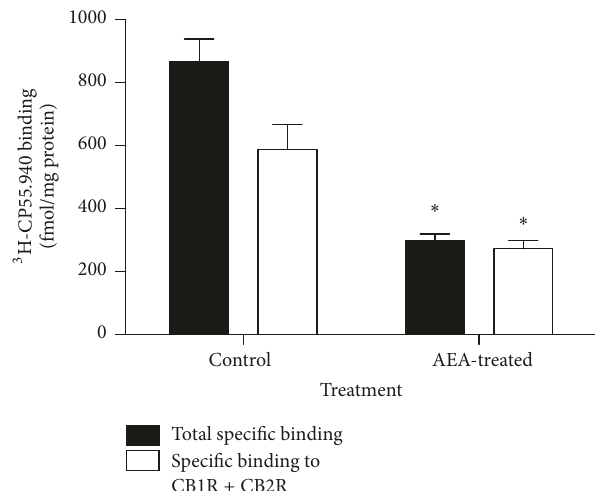
Figure 3: Specific binding of 3 [H]-CP55.940 in hypothalamic membranes of control and AEA-treated 150-day-old mice ( ∗ 𝑃 < 0.05 Mann–Whitney 𝑈 test; mean ± SEM; 𝑛 = 3